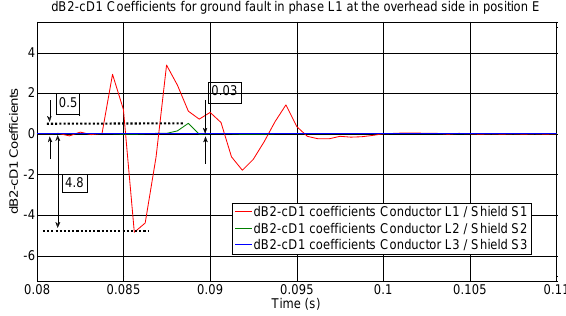
Figure 19. Wavelet analysis of the angular differences with a ground fault at the overhead line side in phase L1. Fault point E.